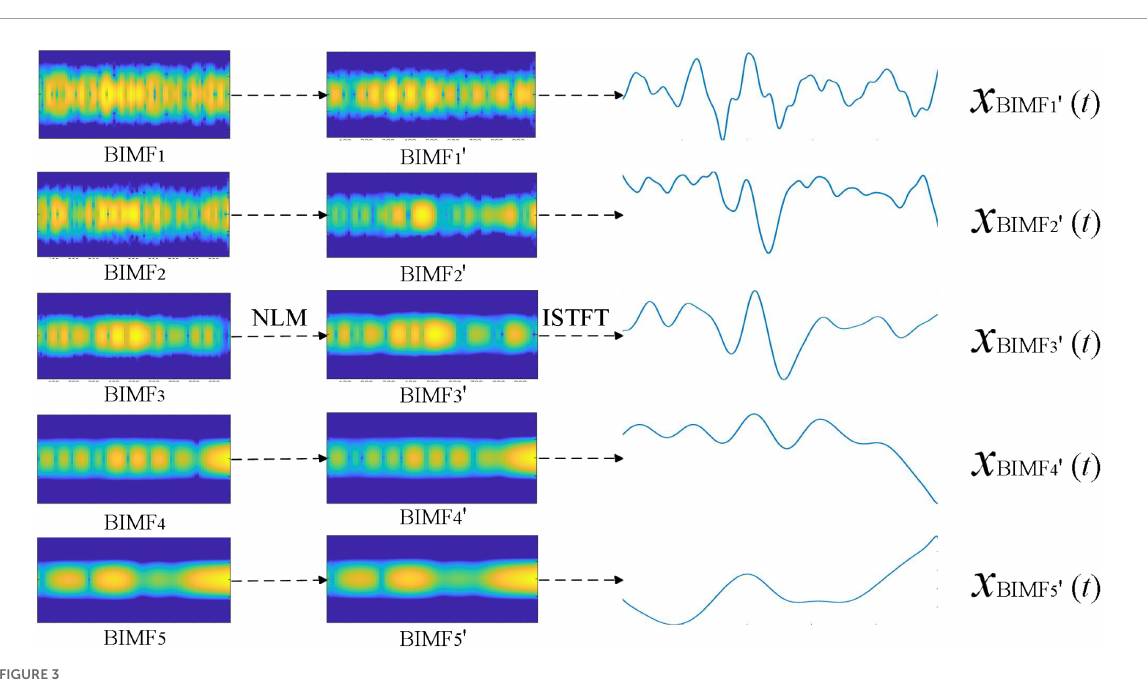
relevant to the reference signal are shown in Figure 6 . As shown, the performance of EEMD-CCA method was the worst. The signal processed by EEMD-CCA completely failed to fit the